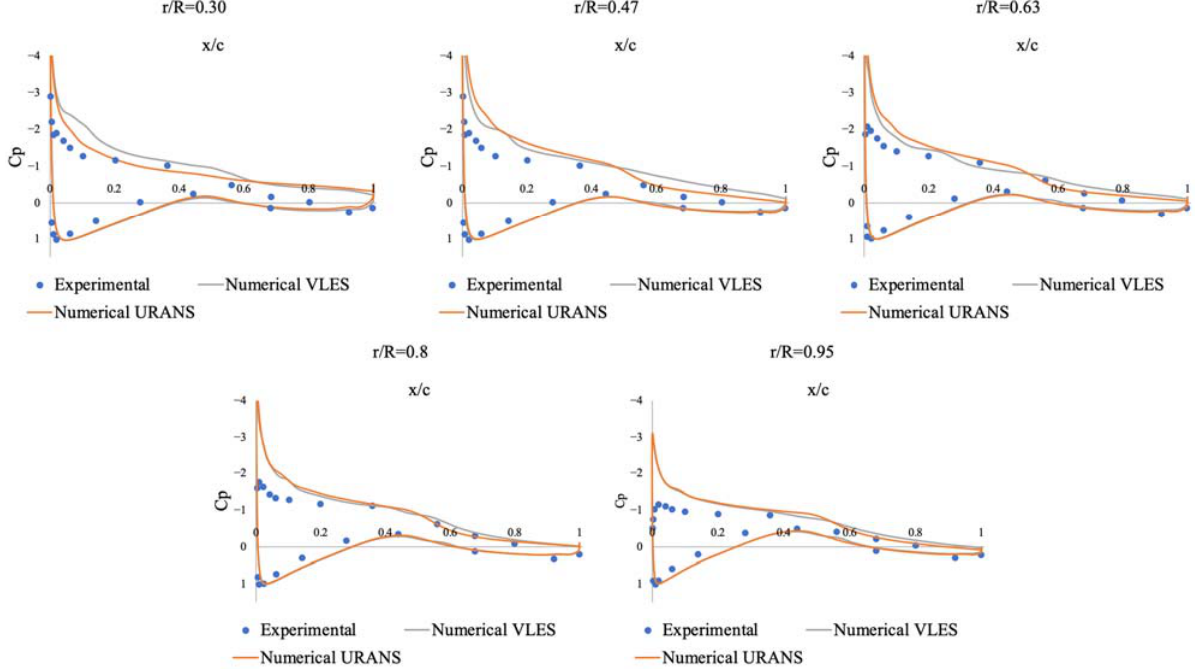
Figure 11. Pressure coefficients for URANS, VLES, and experiment (wind speed = 7 m/s).